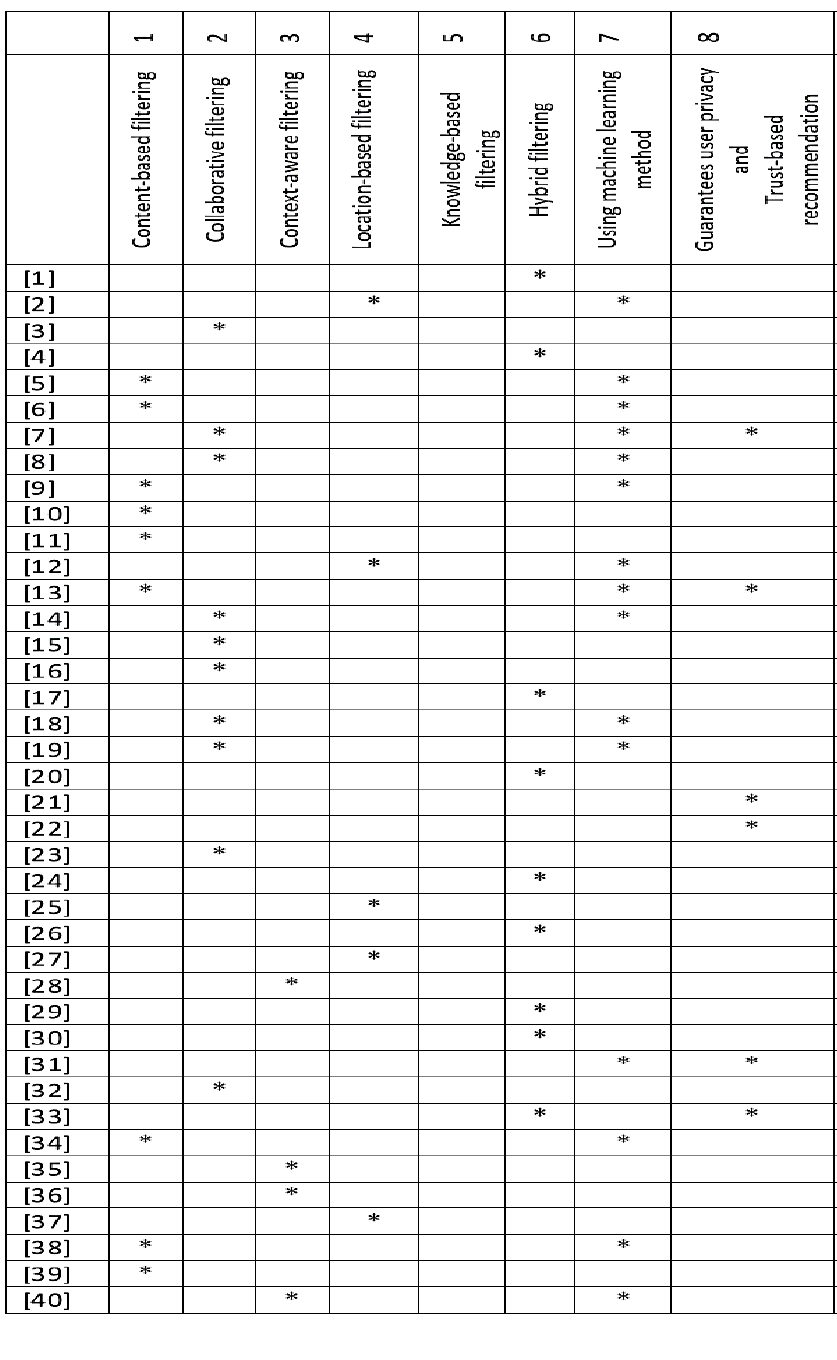
Table 1. Classification of state-of-the-arts